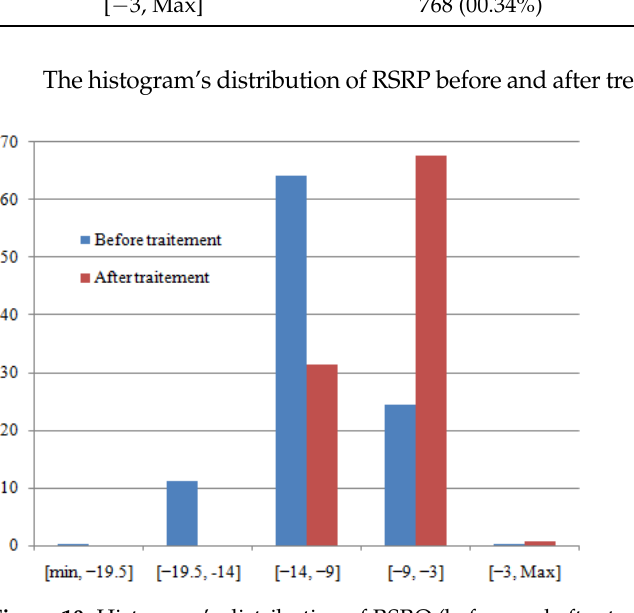
Figure 10. Histogram’s distribution of RSRQ (before and after